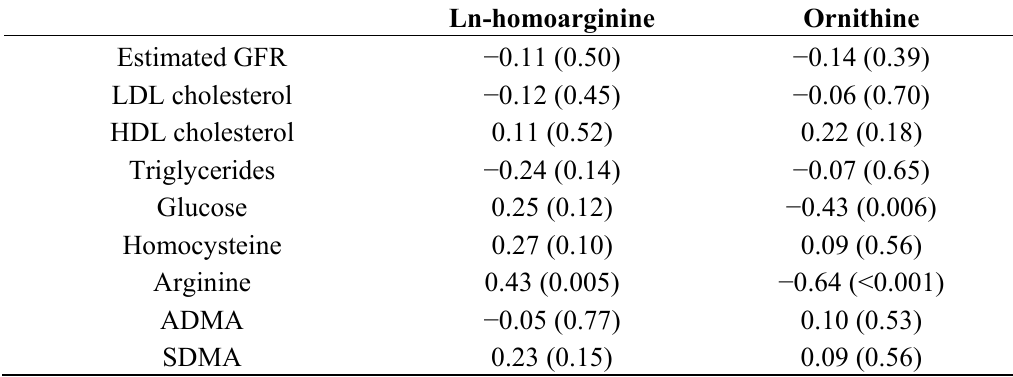
Table 2. Correlation coefficients ( r ) between ornithine or homoarginine and biochemical data. ADMA, asymmetric dimethylarginine; SDMA, symmetric dimethylarginine.